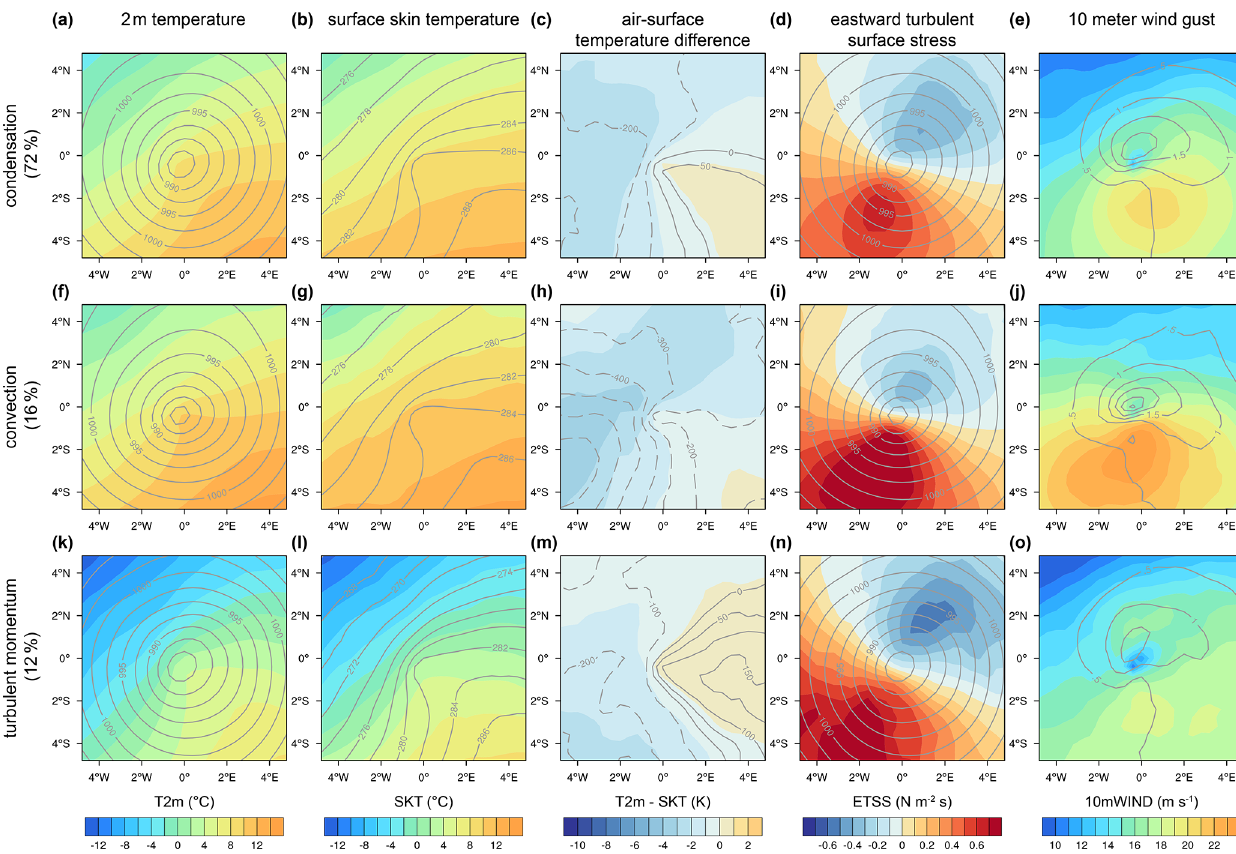
Figure 9. Similar to Fig. 7 but for the positive PV anomaly in the cyclone center in the cold season. Gray contours show sea level pres- sure (a, f, k, e, j, o) , θ at 900hPa (b, g, l) , surface sensible heat flux (c, h, m) , and total precipitation (d, i, n)